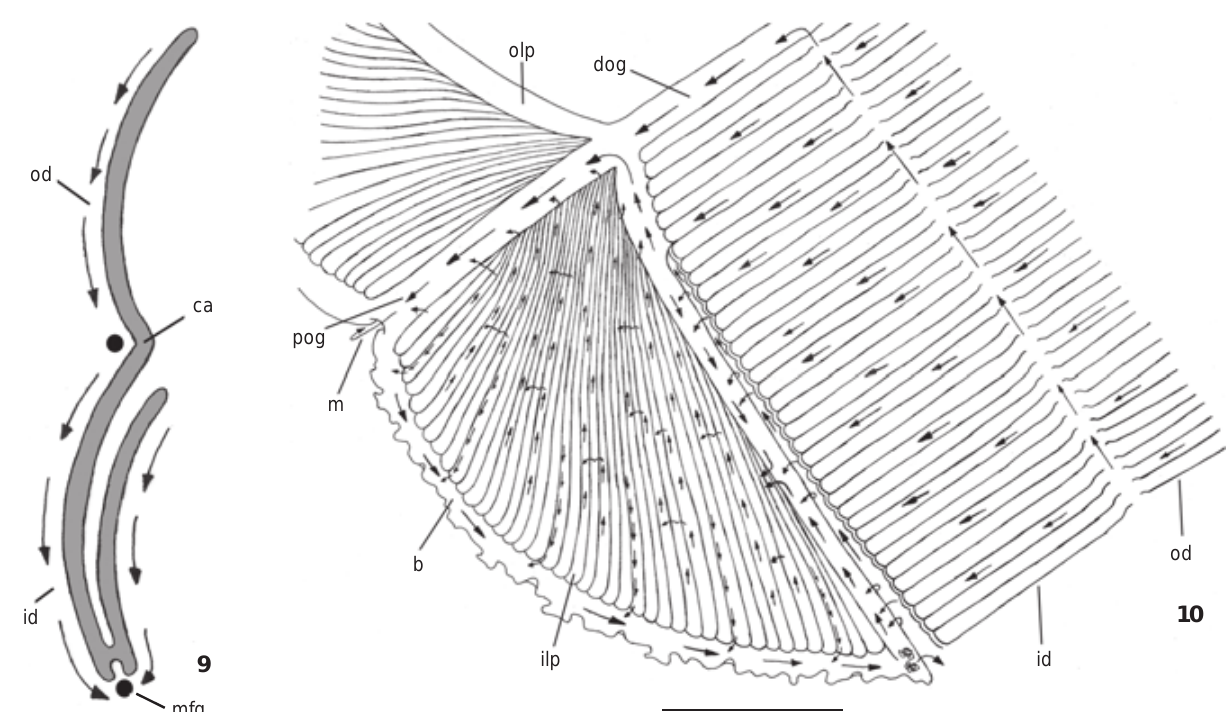
Figures 9-10. Macoma biota . (9) Diagrammatic vertical section through the ctenidium showing its functional organization: arrows ventralward and bullets oralward ciliary currents. (10) Relationship between the left labial palps and inner demibranch, and respective ciliary currents. (b) Rejection current along the ventral smooth border, (ca) ctenidium axis, (dog) distal oral groove, (id) inner demibranch, (ilp) inner labial palp, (m) mouth, (mfg) marginal food groove, (od) outer demibranch, (olp) outer labial palp, (pog) proximal oral groove. Scale bar: 5 mm.